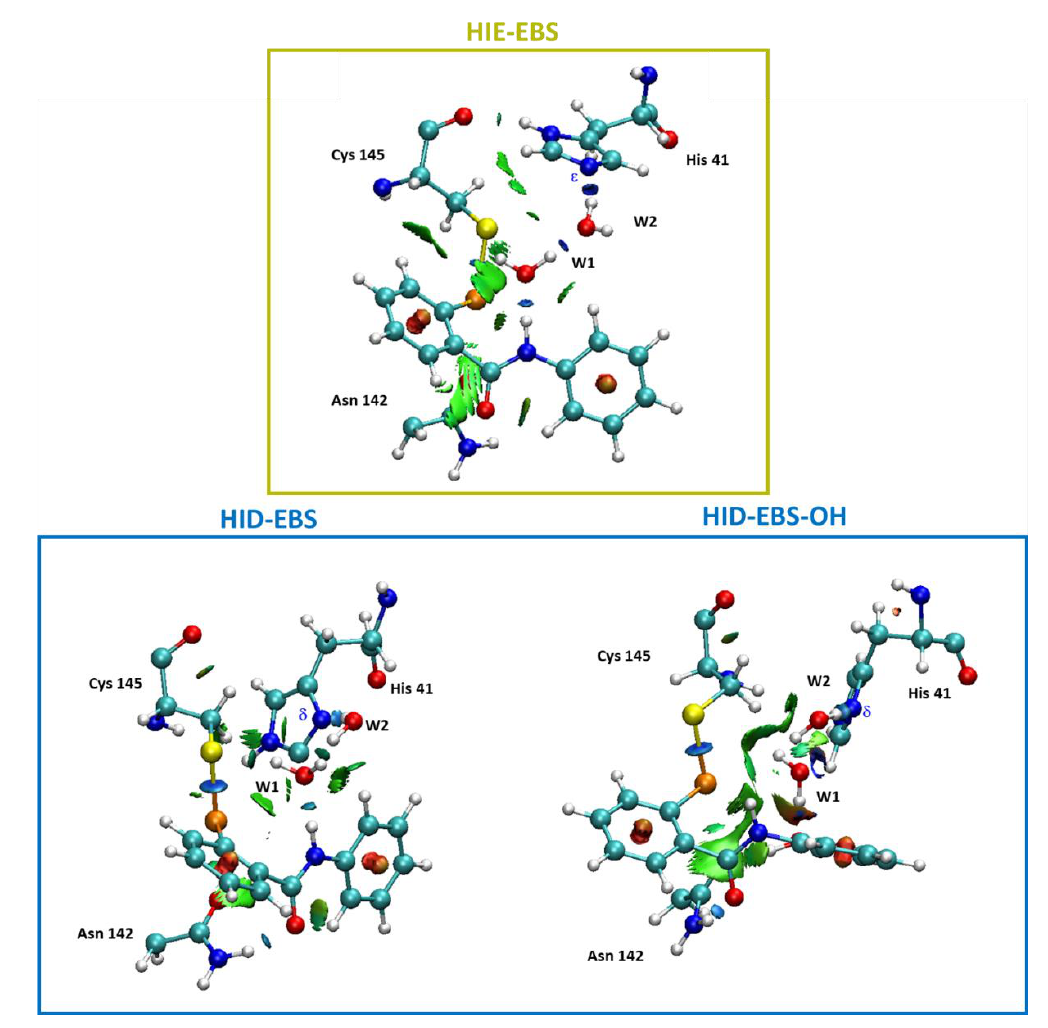
Figure 9. Noncovalent interaction plot calculated for the final covalent complex (E-I) for HIE (in yellow box) and M pro active site HID with EBS and EBS-OH (in blue box). For clarity, only relevant residues were kept.